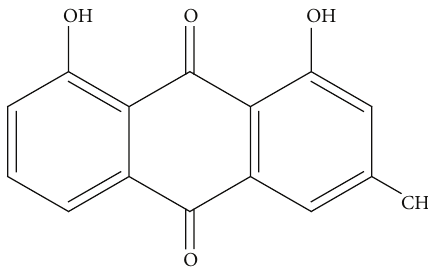
Figure 2: The chemical structure of